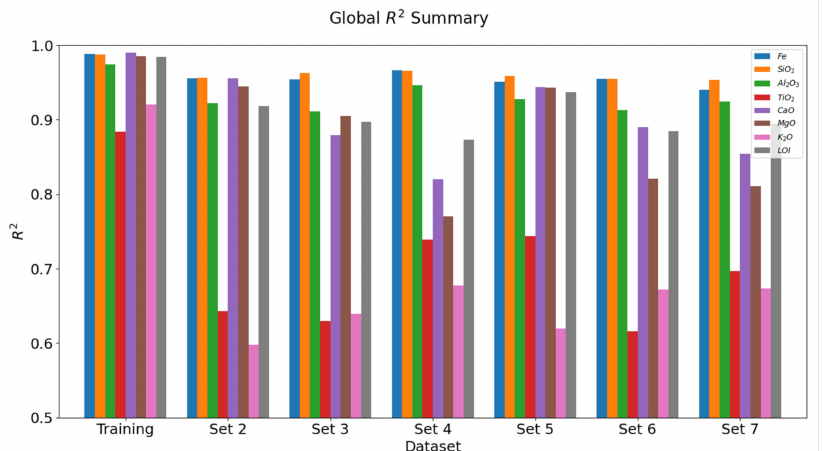
Figure 2. The calculated R 2 scores for each of the six testing datasets (sets 2–7) and the training and validation dataset (simply given as Training) for the eight whole-rock parameters modeled. The training and validation data return high R 2 scores overall which are found to generally decrease when the model was applied to the testing datasets. The reduction in the overall R 2 scores was most pronounced in the TiO 2 , CaO, MgO and K 2 O parameters whose values low for most of the data and are considered as consisting of primarily background (refer to Figure 4). Table 3. The R 2 score, RMSE and standard deviation of the RMSE for the eight whole-rock geo- chemical parameters used for training and validation data and the six individual test data sets. The number of drillcore for a given dataset are given in the first column with each dataset comprising approximately 25,000 samples. The results are calculated on a per-dataset basis and represent global results per